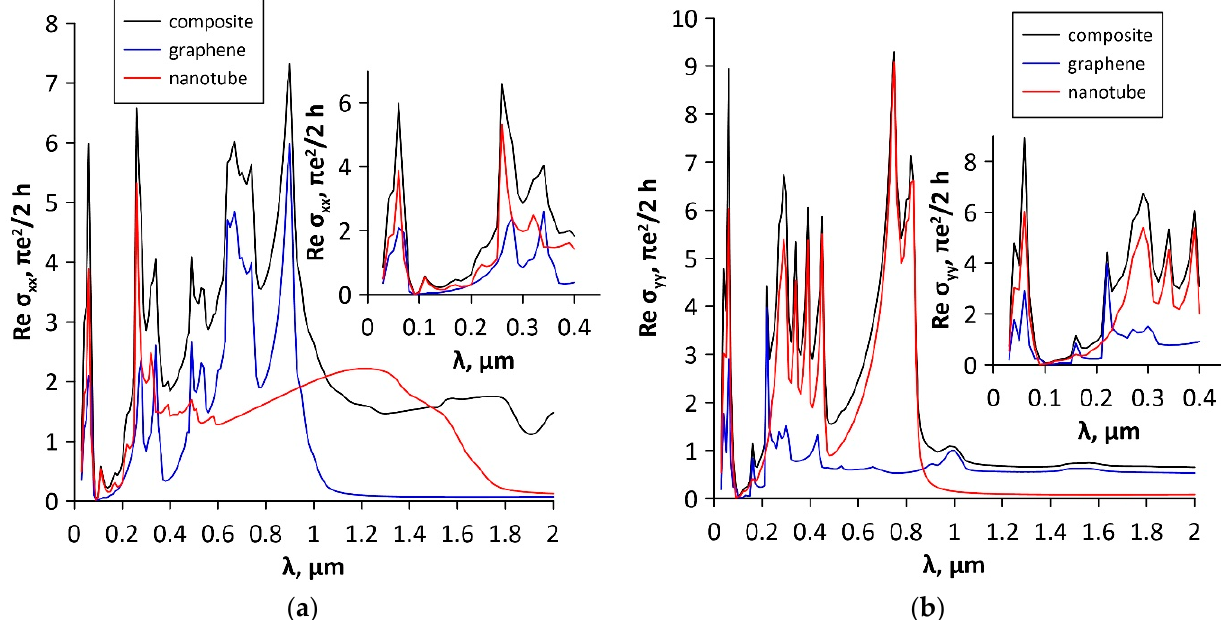
Figure 2. Profiles of the real part of the diagonal elements of the optical surface conductivity tensor for topological model V1 of a graphene-SWCNT (12,6) composite film: ( a ) with polarization along the X axis; ( b ) with polarization along the Y axis.